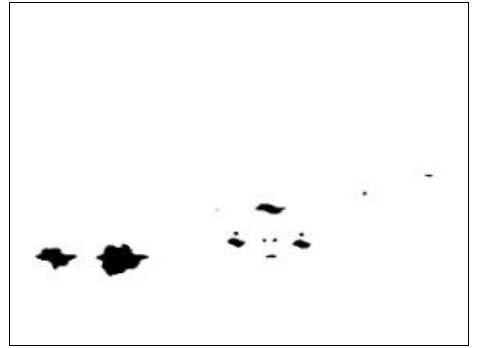
Figure 5. Results of performing the bright object segmentation module on the road scene images in Figure